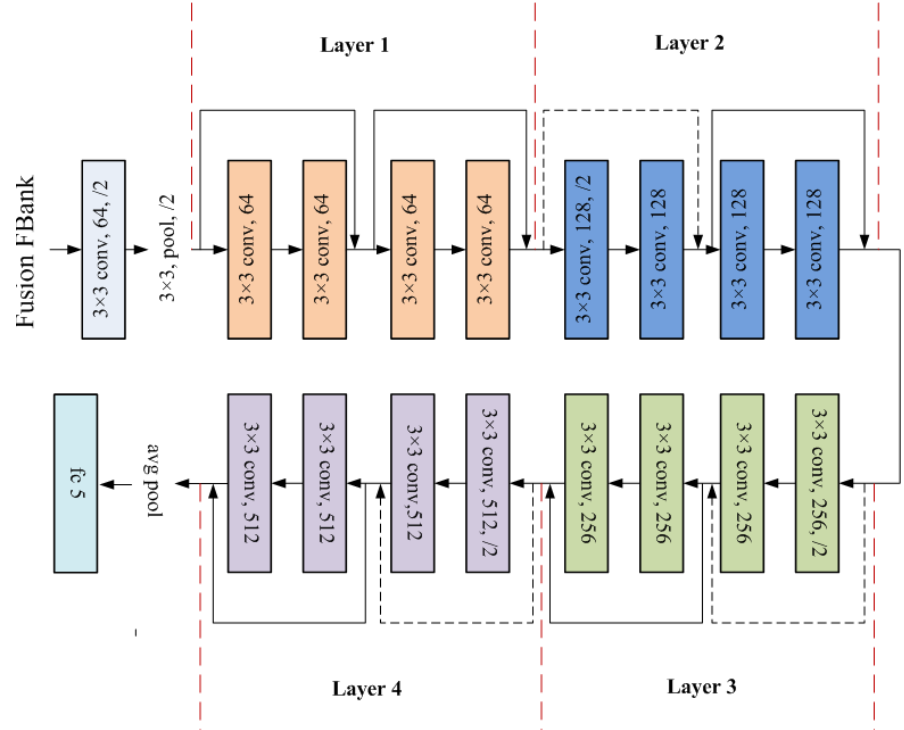
Figure 4. The structure of modified ResNet18.